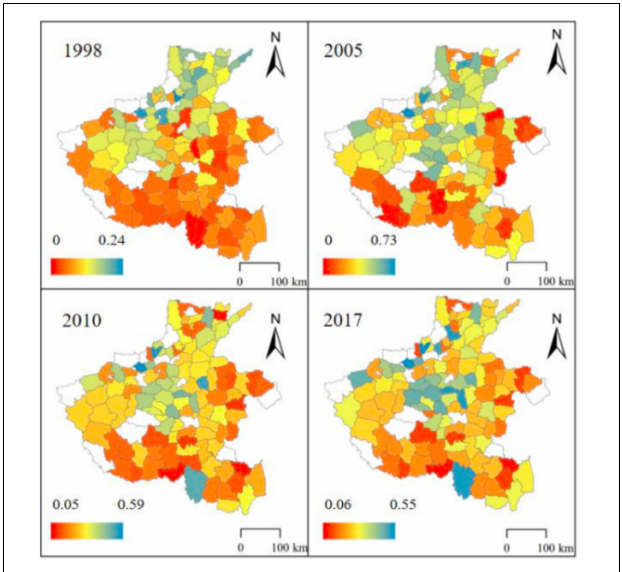
FIGURE 10 | Spatial differences in the ecological safety maintenance function of cultivated land in Henan